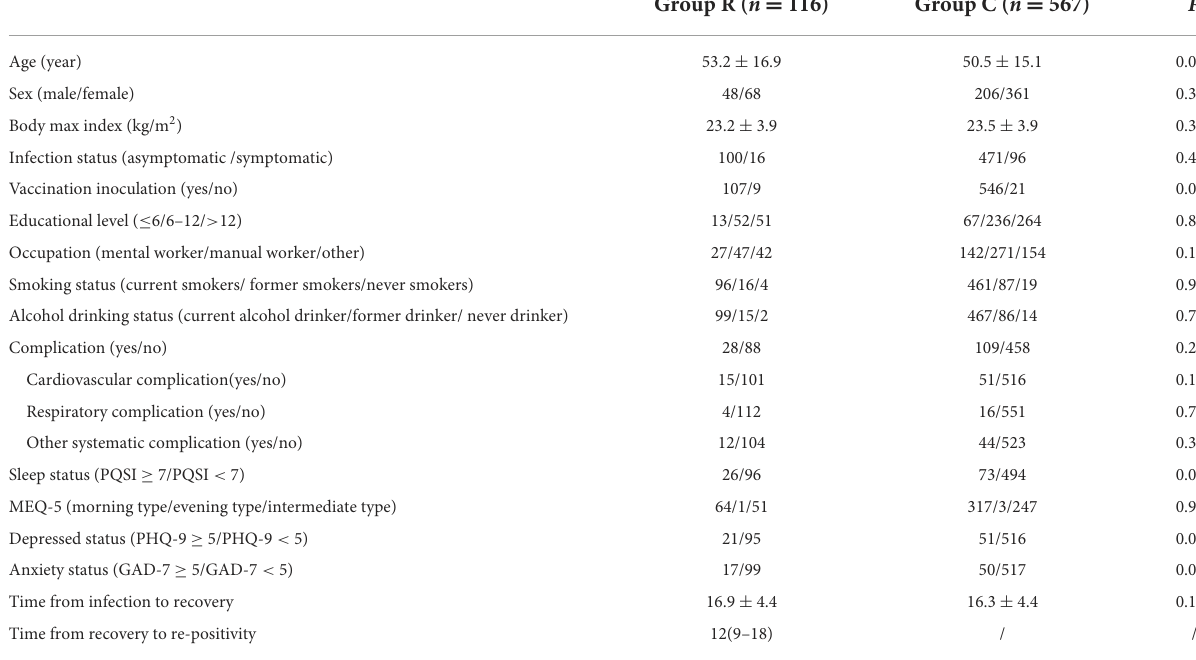
TABLE 1 Demographic characteristics, data of psychological and sleep evaluation between patients in re-positivity and control